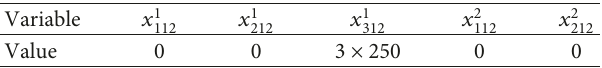
Table 10: The amounts of transported goods to supplementary origin C1.